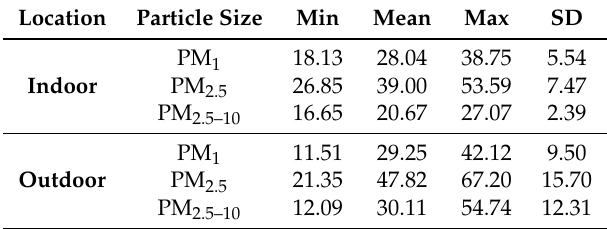
Table 2. Descriptive statistics of the indoor and outdoor particle mass concentration ( µ g/m 3 ).